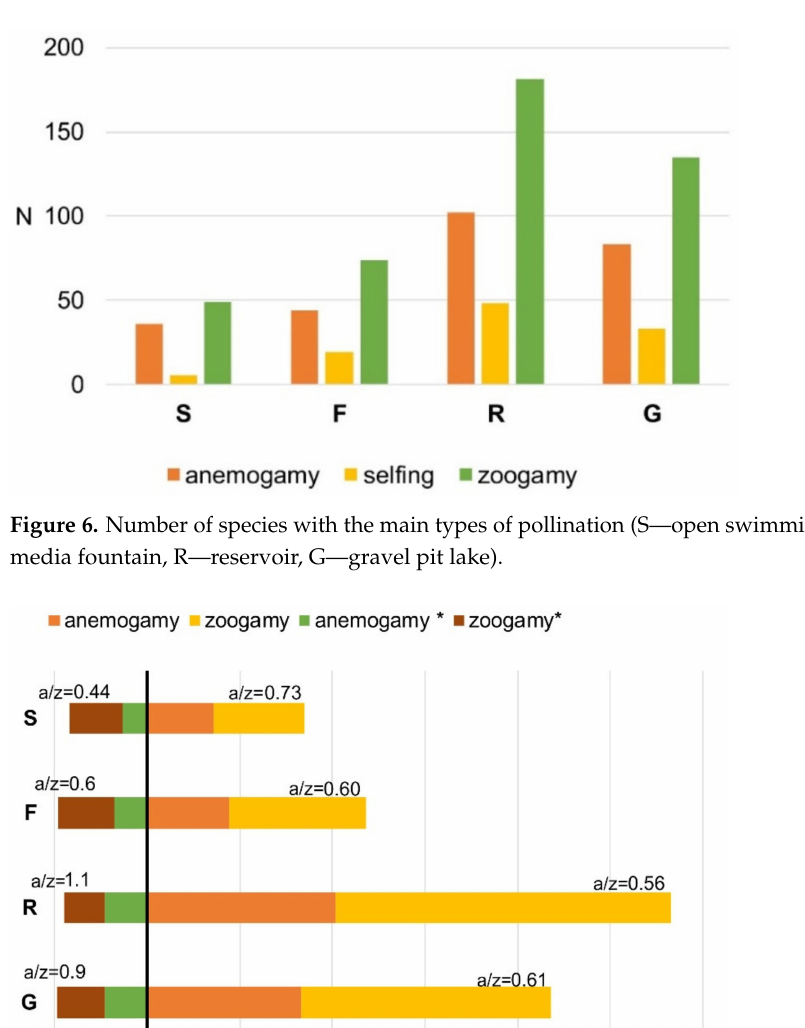
Figure 5. Number of species of different ecological types (S—open swimming pools, F—multi-media fountain, R—reservoir, G—gravel pit lake).